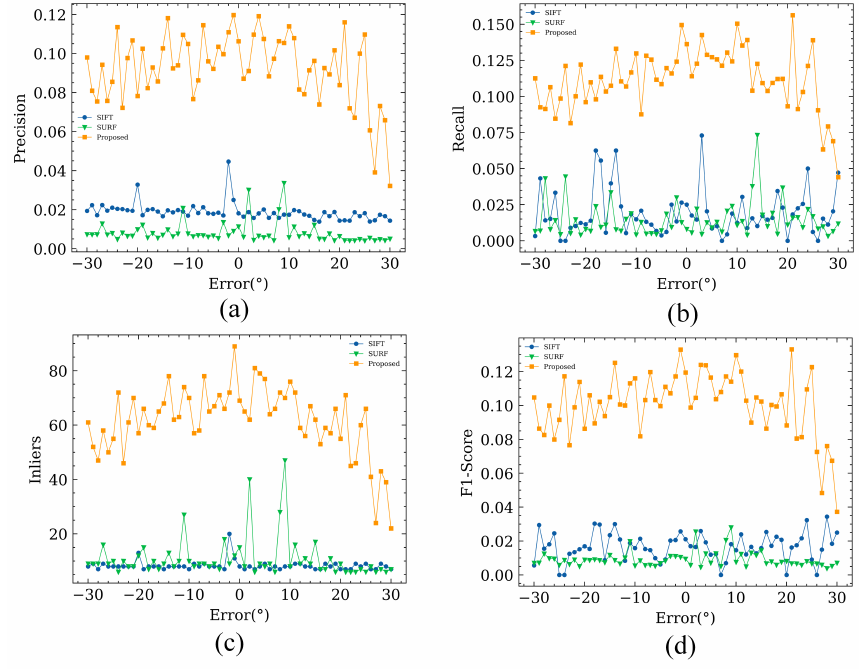
Figure 20. Quantitative comparison of interference fringe-matching algorithms in the attitude error experiment. ( a ) Precision. ( b ) Recall. ( c ) Inliers. ( d )